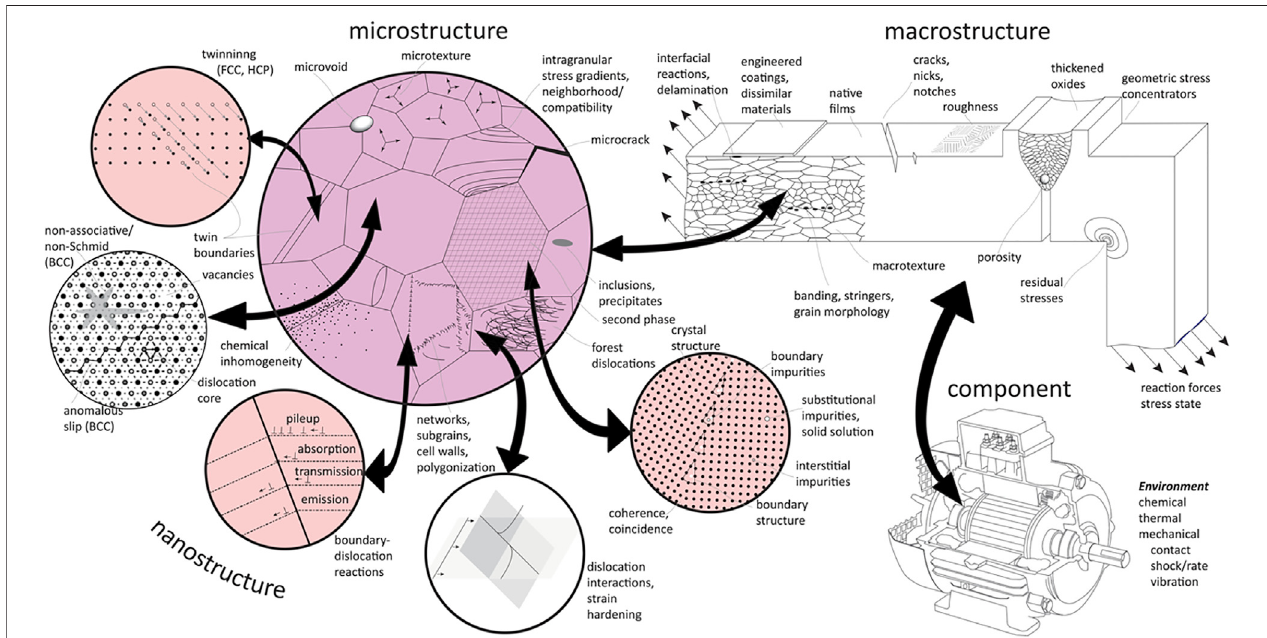
FIGURE 1 | A schematic depiction of the multiscale and multi-physics nature of material systems and their relationship with the component performance. A comprehensive understanding of material performance requires a complete hierarchical representation of structural/chemical features, the relationship between those features and material properties, and the mechanisms that drive their evolution either through processing or service history. All arrows represent scale bridging, i.e., upscaling via homogenization and downscaling via localization.